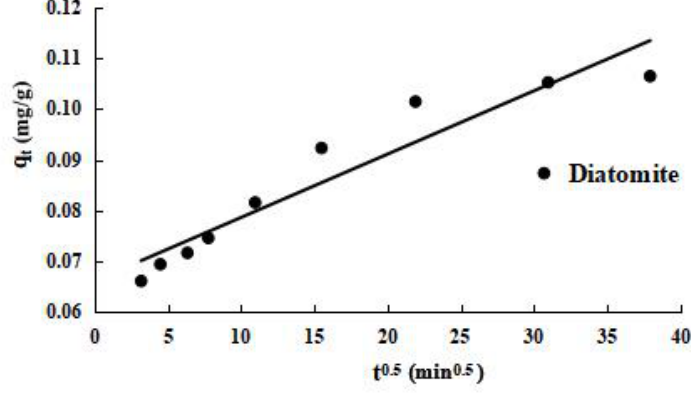
Figure 7. Adsorption curve of diatomite for q t onto t 0.5